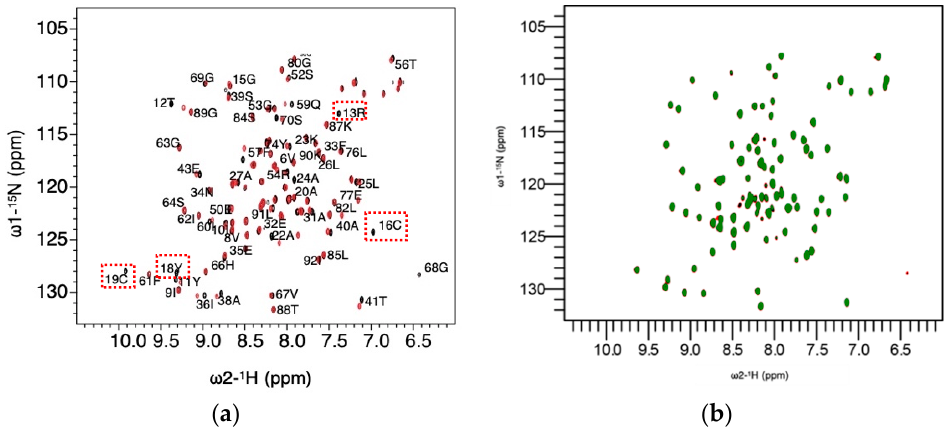
Figure 2. Chemical shift perturbation of copper ions ( a ) CSP of Cu(I) titrated GRX (red) reveals chemical shifts in the CPYC active site (red boxes). ( b ) Overlay of Cu(I) (green) and Cu(II) (red) shows nearly identical chemical shift perturbations upon ligand binding.